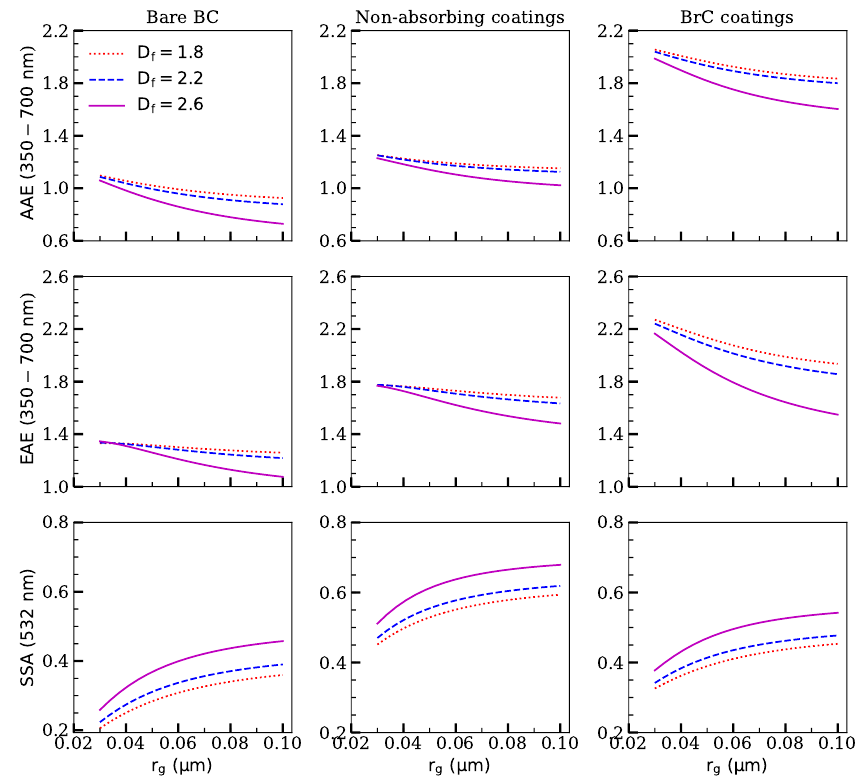
Figure 4. Radiative properties of thinly-coated BC as the function of r g at different D f ( σ g = 1.5, BC/OC = 0.375 for coated